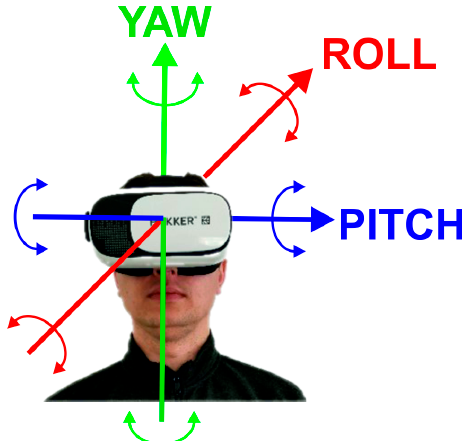
Figure 10. Orientation of VR goggles. Source: prepared by the author.